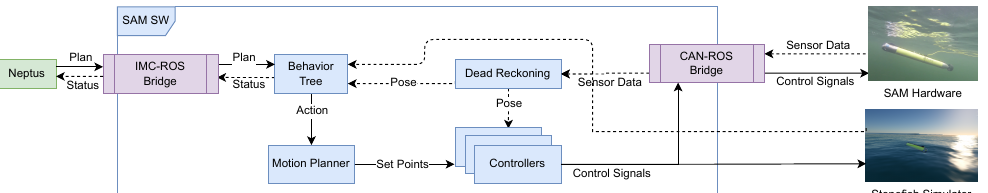
Figure 4. The SAM cyber-physical system architecture integrating a user interface, software, hard- ware, and simulation